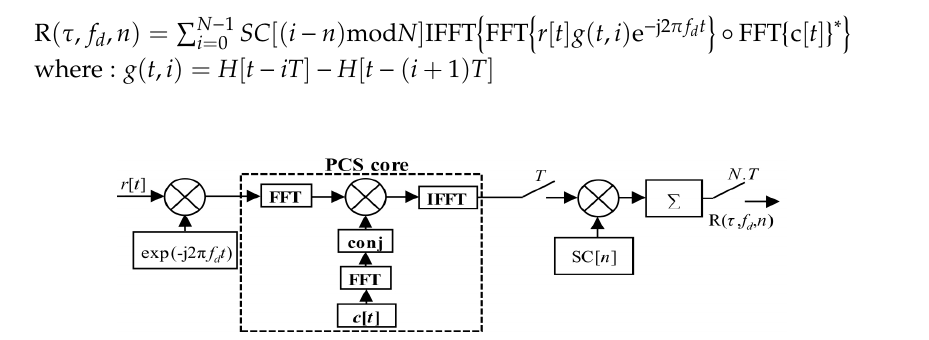
Figure 3. Acquisition schema using PCS, the straightforward single-step post-correlation approach.